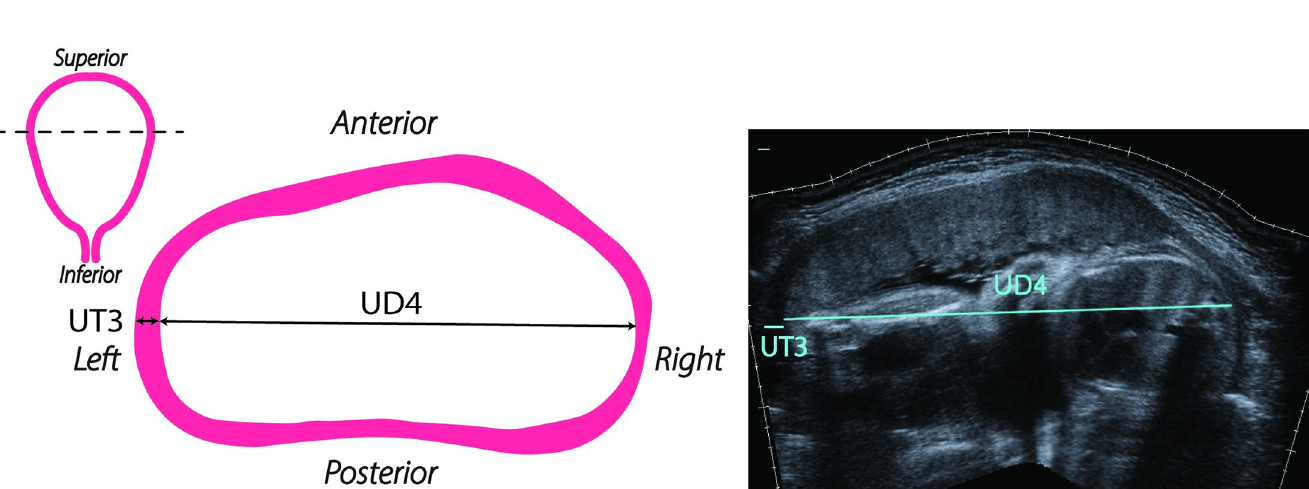
PLOS ONE | https://doi.org/10.1371/journal.pone.0242118 January 28,